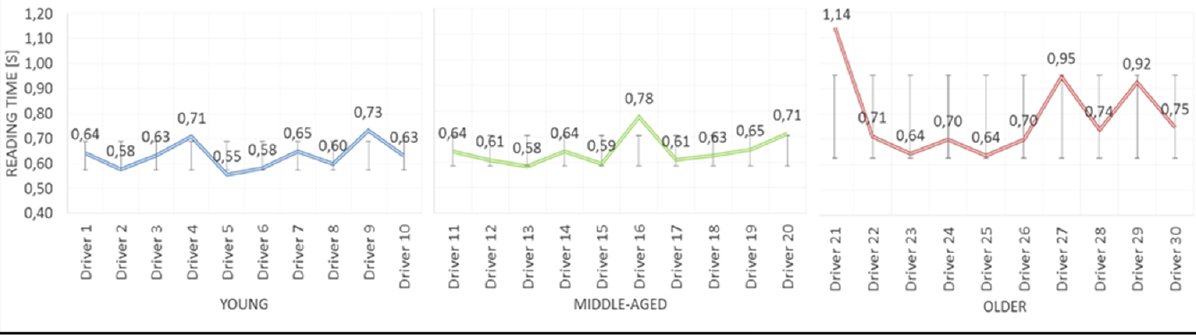
Table 3. Results of the Wilcoxon signed-rank test.